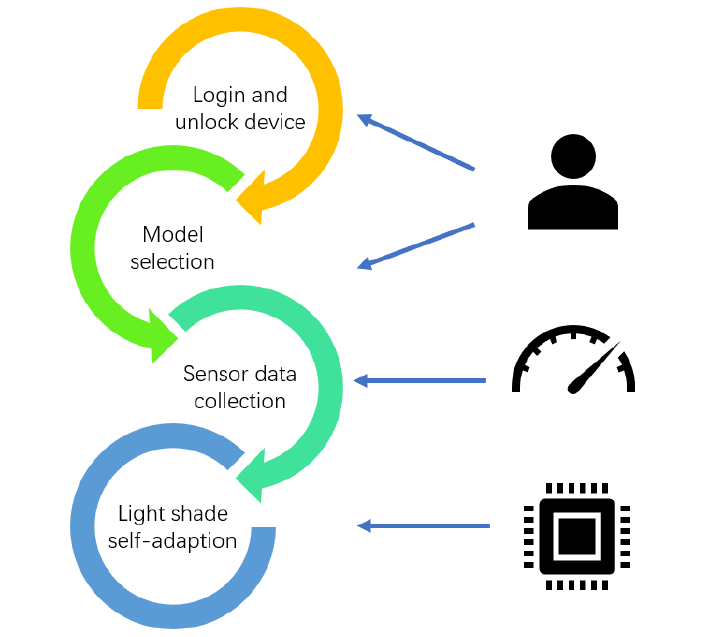
Figure 7. The the workflow of the smart light shade control system [99].